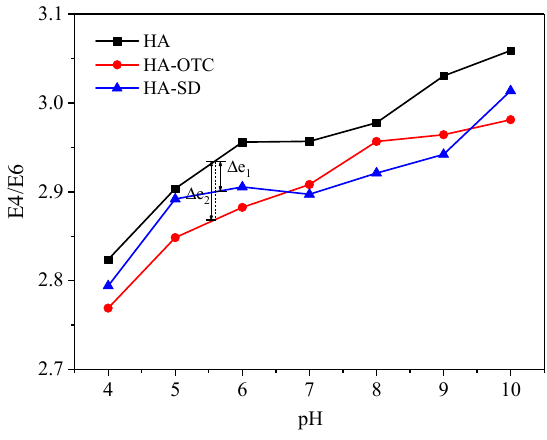
Figure 9. The E4/E6 of HA under different pH conditions.